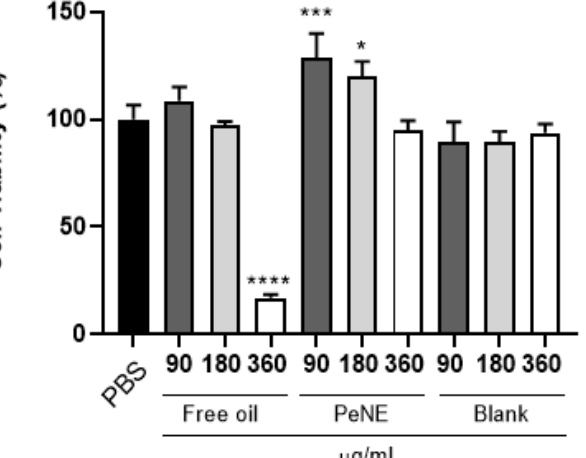
used as the control. ( a ) Histogram representation. Legend: not-treated cells (gray line); NePE-AlClPt treated cells for 30 min (green line), 60 min (red line), and 120 min (orange line). ( b ) Graphical representation. One-way ANOVA: significant difference between groups vs. control * p < 0.05 (Tukey post hoc test).